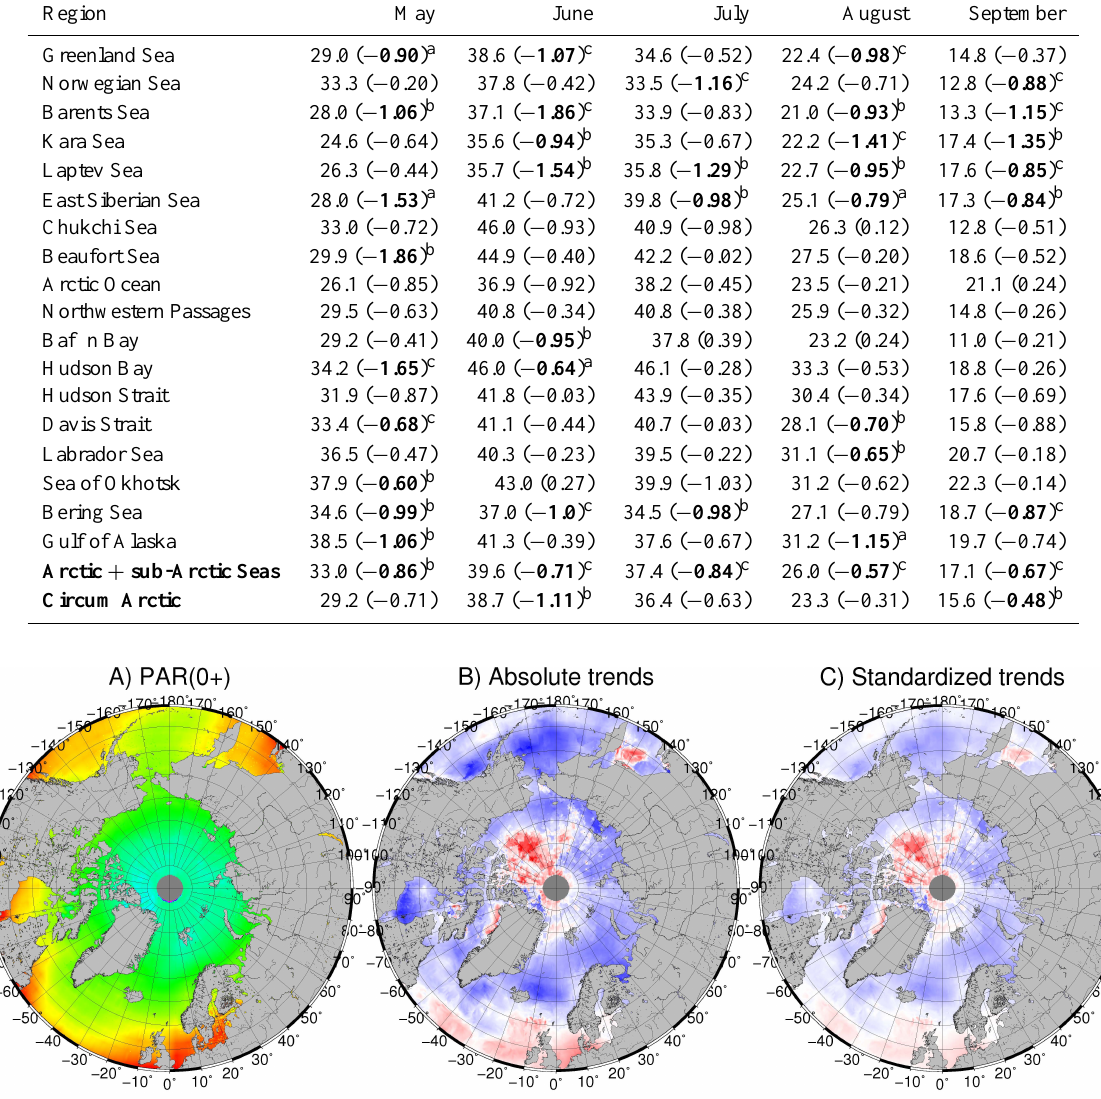
Table 1. Regionally averaged daily flux of PAR above the sea (ice) surface (PAR(0 + ) in mol photon m − 2 d − 1 ) and its relative trends computed for the 1998 to 2009 period (in parenthesis, in %yr − 1 ). Significant trends are in bold text with superscript indicating the level of